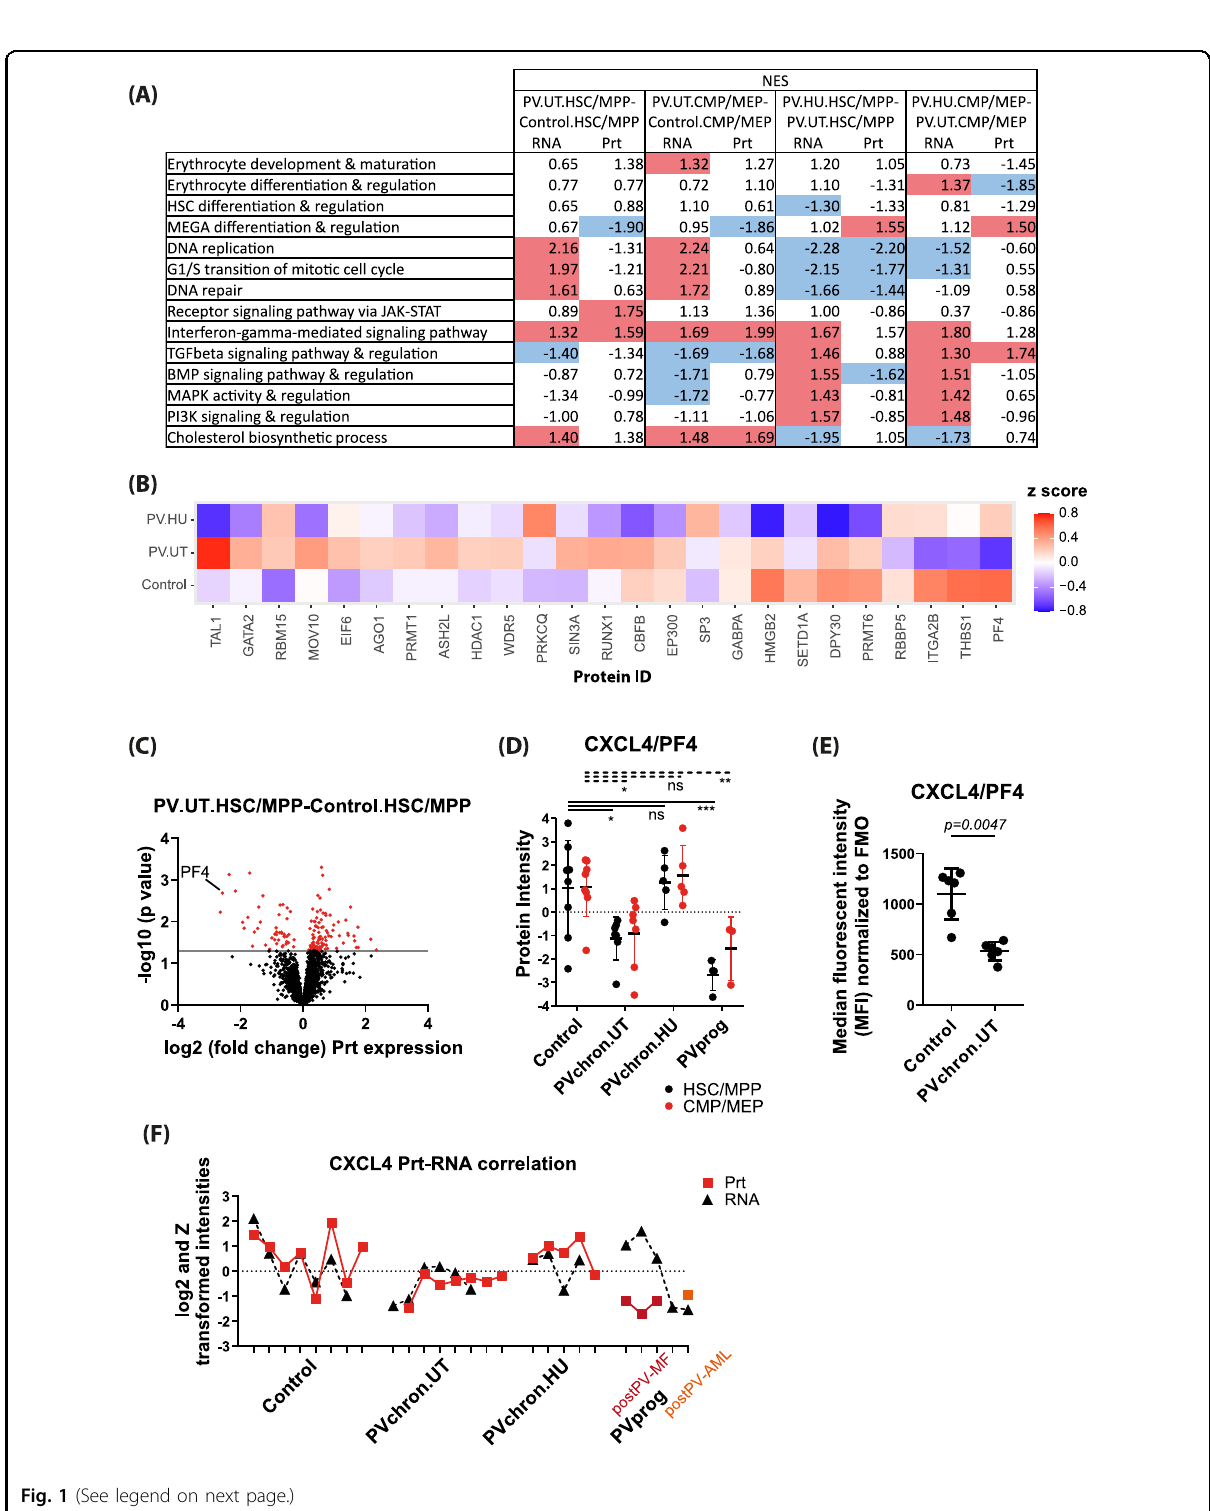
but not RNA level, whereas interferon-gamma signaling was not affected by the treatment of patients with hydroxyurea (Fig. 1A).